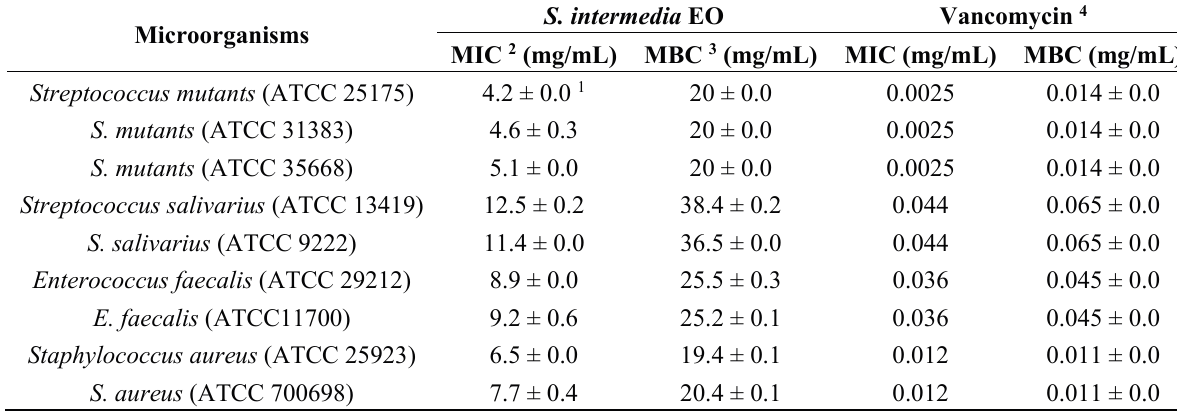
Table 3. Antibacterial activity of Satureja intermedia C.A.Mey EO.